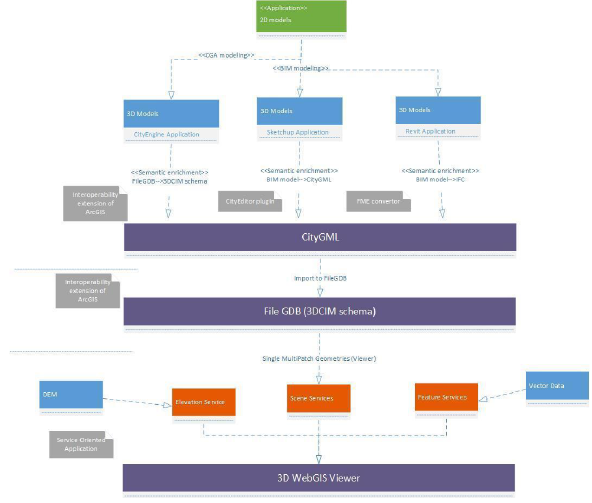
Figure 1. Methodological steps